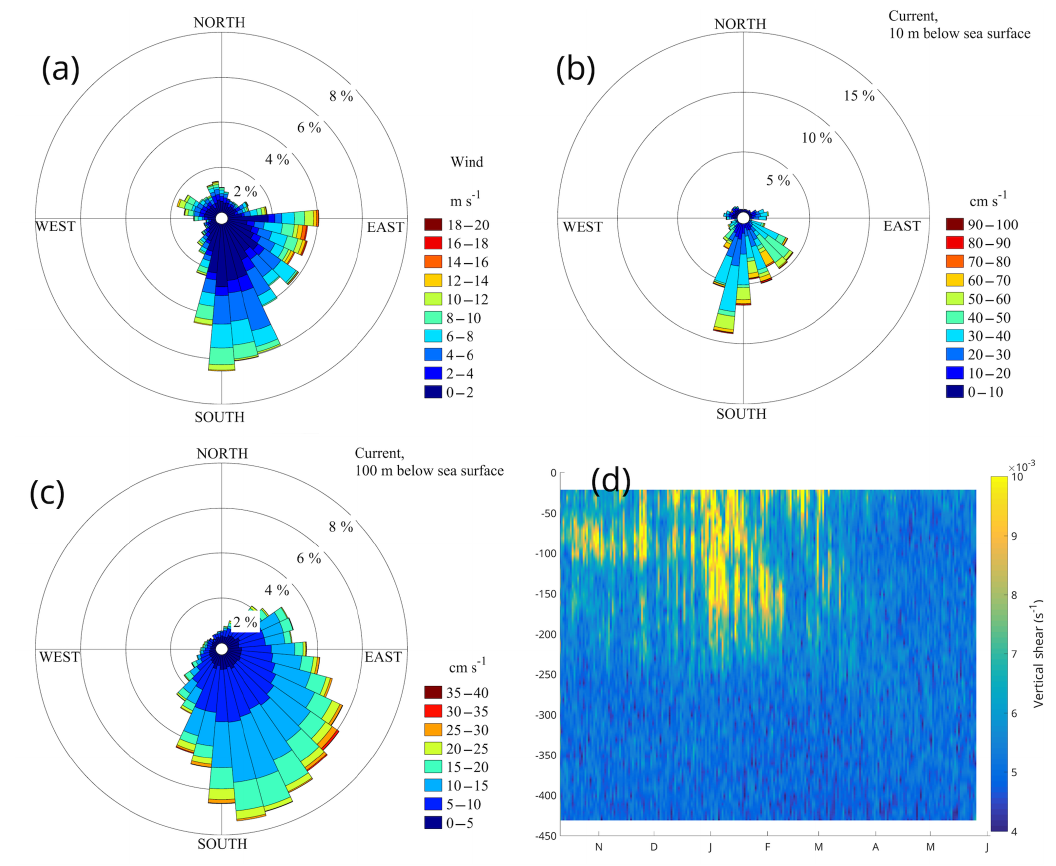
Figure 4. Rose diagrams of wind (a) and surface (10m depth) currents from the buoy’s ADCP (400kHz downward looking) (b) , subsurface currents at 100m depth from the upward looking 75kHz ADCP (c) and vertical shear from the fourth deployment (d) . The direction in panels (a) , (b) and (c) point to the direction of the